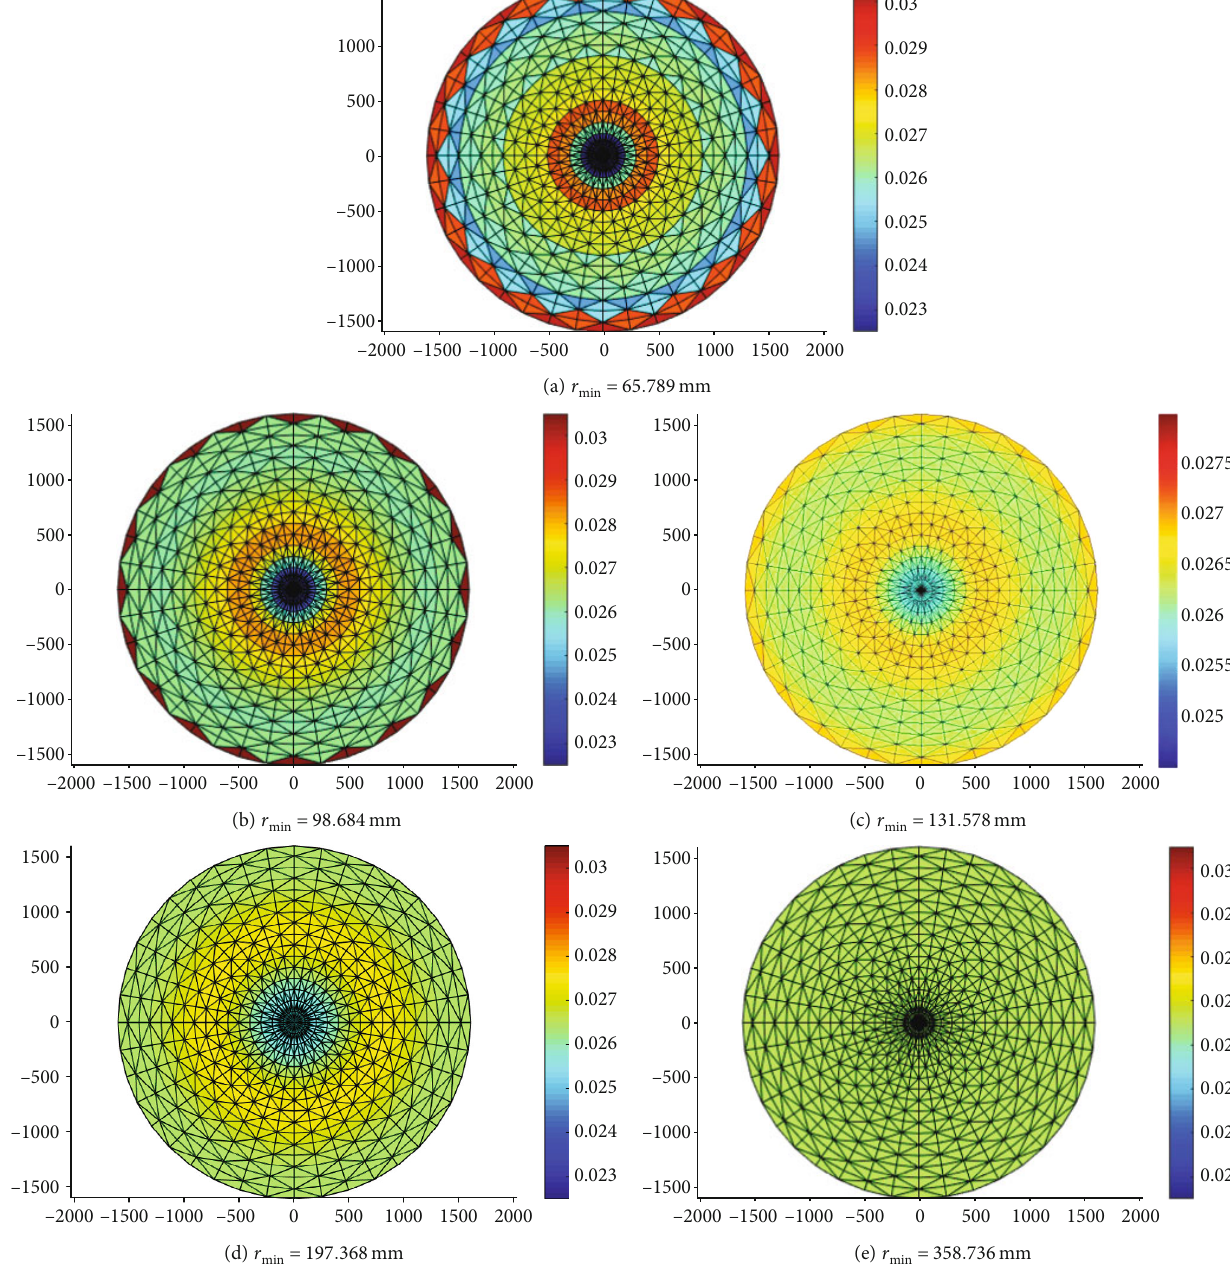
Figure 7: E ff ect of fi lter radius on the optimized re fl ector thickness